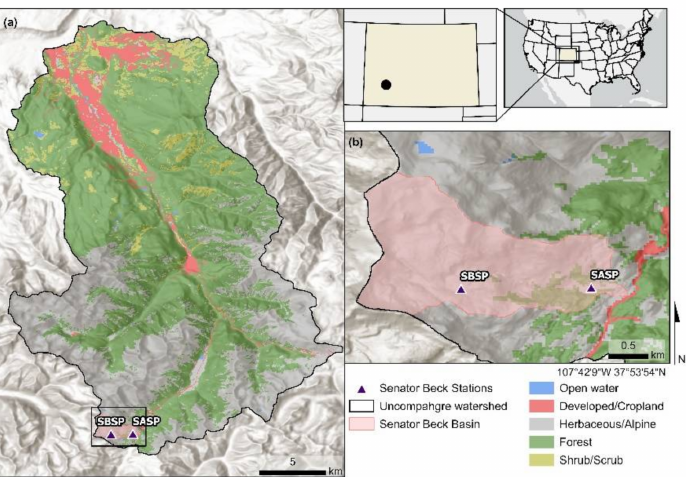
Figure 2. Location map of ( a ) the Uncompahgre River at Ouray and ( b ) Senator Beck Basin within the state of Colorado (middle-upper inset with the study basins identified by the black dot), within the U.S. (right-upper inset). The locations of SBSP and SASP are illustrated within SBB in ( b ). The 10-m digital elevation model was obtained from the National Elevation Dataset via the USDA-NRCS Geospatial Data Gateway (https://datagateway.nrcs.usda.gov/, accessed on 1 March 2021) and the land cover data are the 2016 National Land Cover Database (https://www.mrlc.gov/, accessed on 1 March